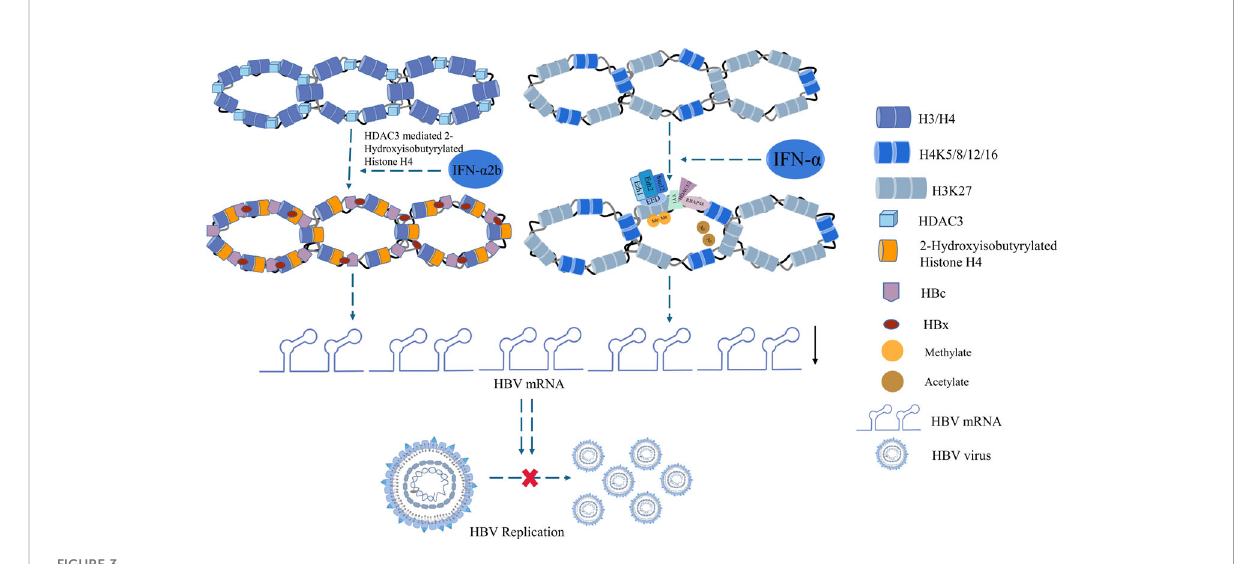
FIGURE 3 Histone acetylation involved in IFN